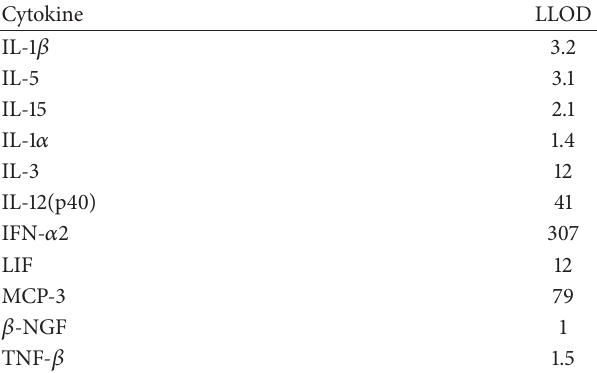
Table 2: Cytokines and chemokines not detected in any group, either because they are under the lower limit of detection (LLOD, pg/mL) or because they are not produced, and